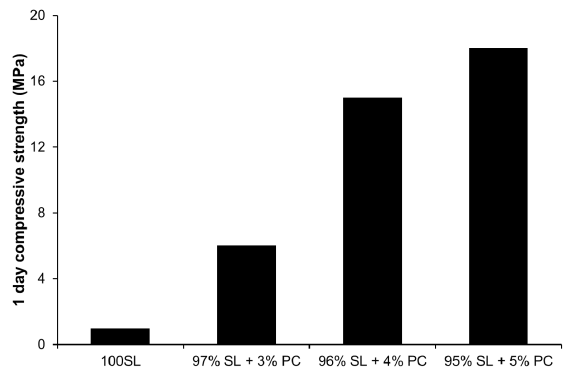
Figure 5: Effect of PC on 1-day compressive strength (adapted from [34])